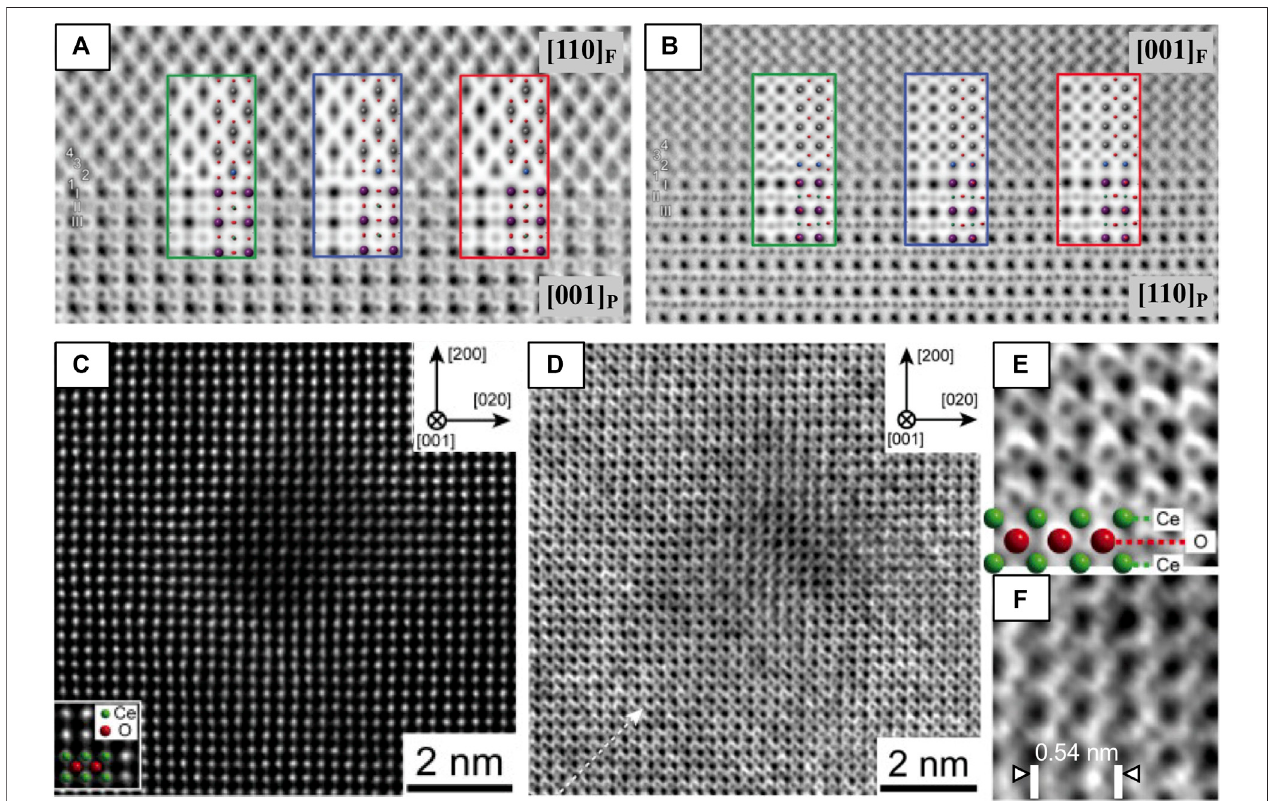
FIGURE8| HAADFandABF-STEMimagesusedto (A,B) clarifysurfaceterminationlayeratanLAO-LZOinterfaceandto (C – F) investigatetheoxygensublatticeof CeO 2 after swift heavy ion irradiation. ABF-STEM images of the LaAlO 3 /La 0.5 Zr 0.5 O 1.75 interface along the (A) [001]P and (B) [110]P zone axes. Three models of the fl uorite/LaAlO 3 interfaceandtheirsimulatedABF-STEMimageswerecomparedwithexperimental imagestomapthecationandanionpositions.Comparisonofimages and models in both (A,B) shows that the O 2 -terminated (green) model matches best along the two zone axes, with each cation/anion accounted for by the model. Reproduced from reference (O ’ Sullivan et al., 2016). (C) HAADF-STEM and (D) ABF-STEM images of an ion track in CeO 2 [001] formed by Xe ion irradiation, with magni fi ed views ofthe (E) peripheral and (F) core damage regions of the ion track. Atomic models ofCeO 2 are shown in the insets of (C,E) . Reproduced from